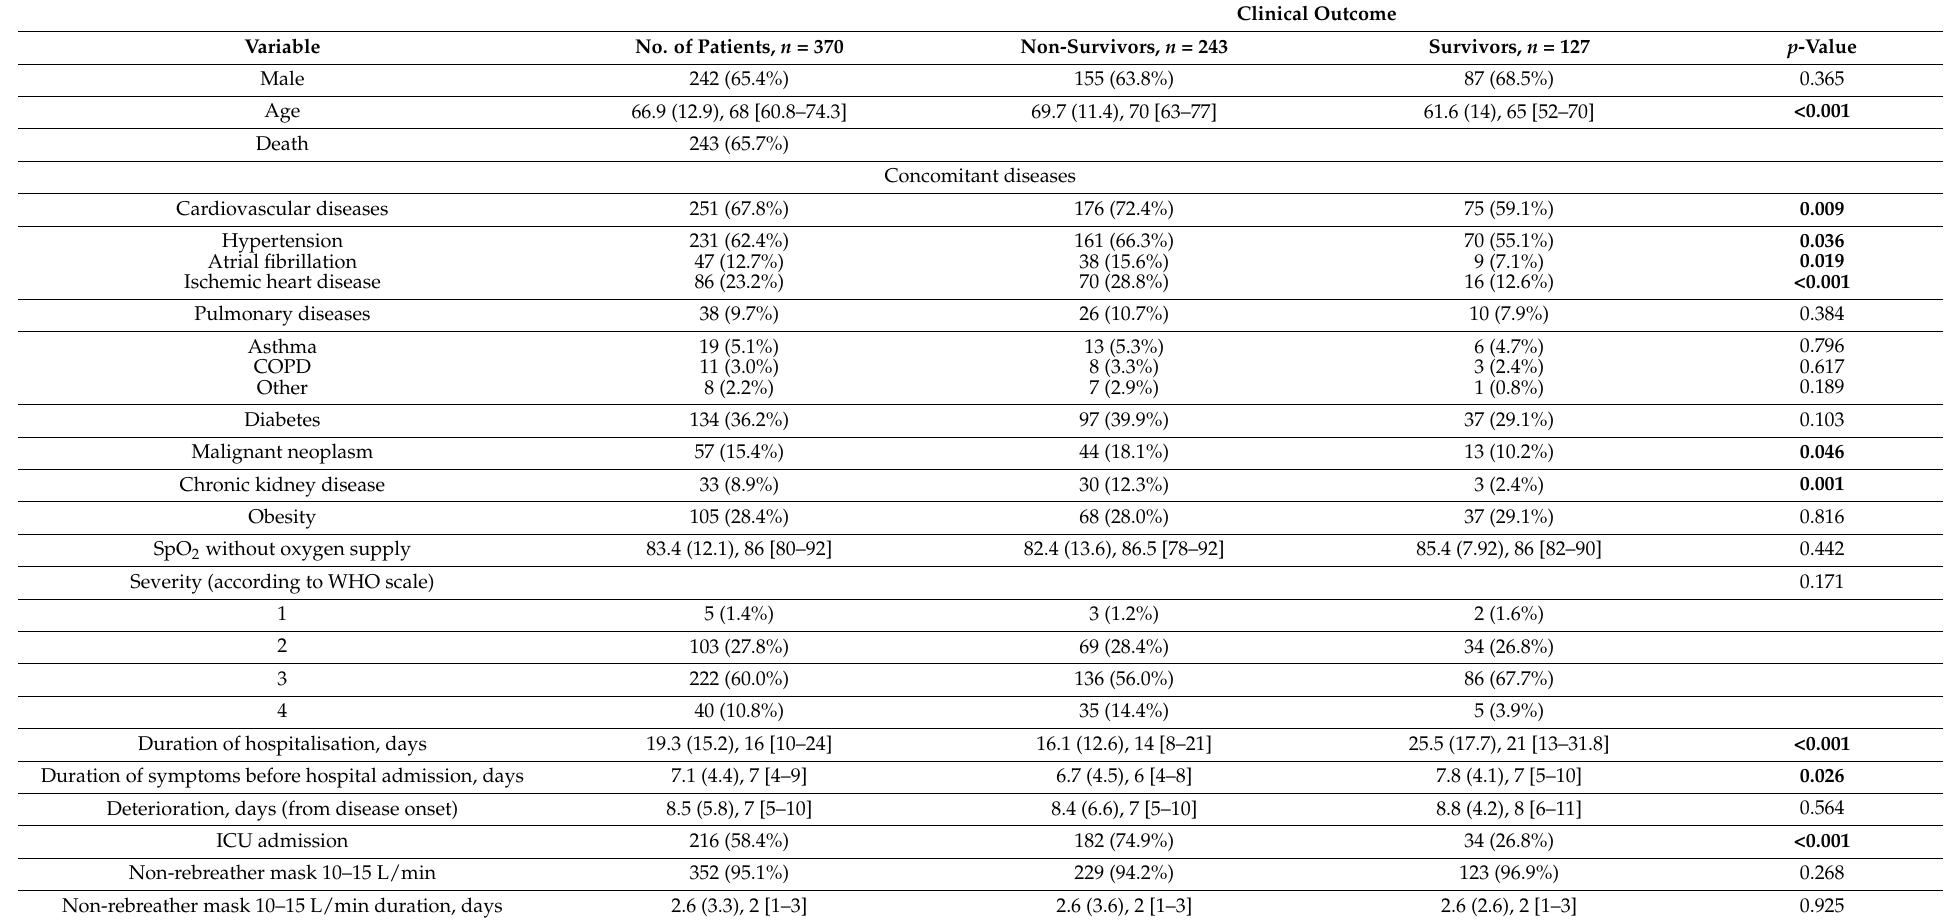
Table 1. Characteristics of the group—the variables relate to the time of admission to the hospital; quantitative parameters and variables are presented as mean values (standard deviation-SD), median [interquartile range-IQR]; qualitative variables are presented as frequency/number. Standards for laboratory parameters are given in brackets next to each